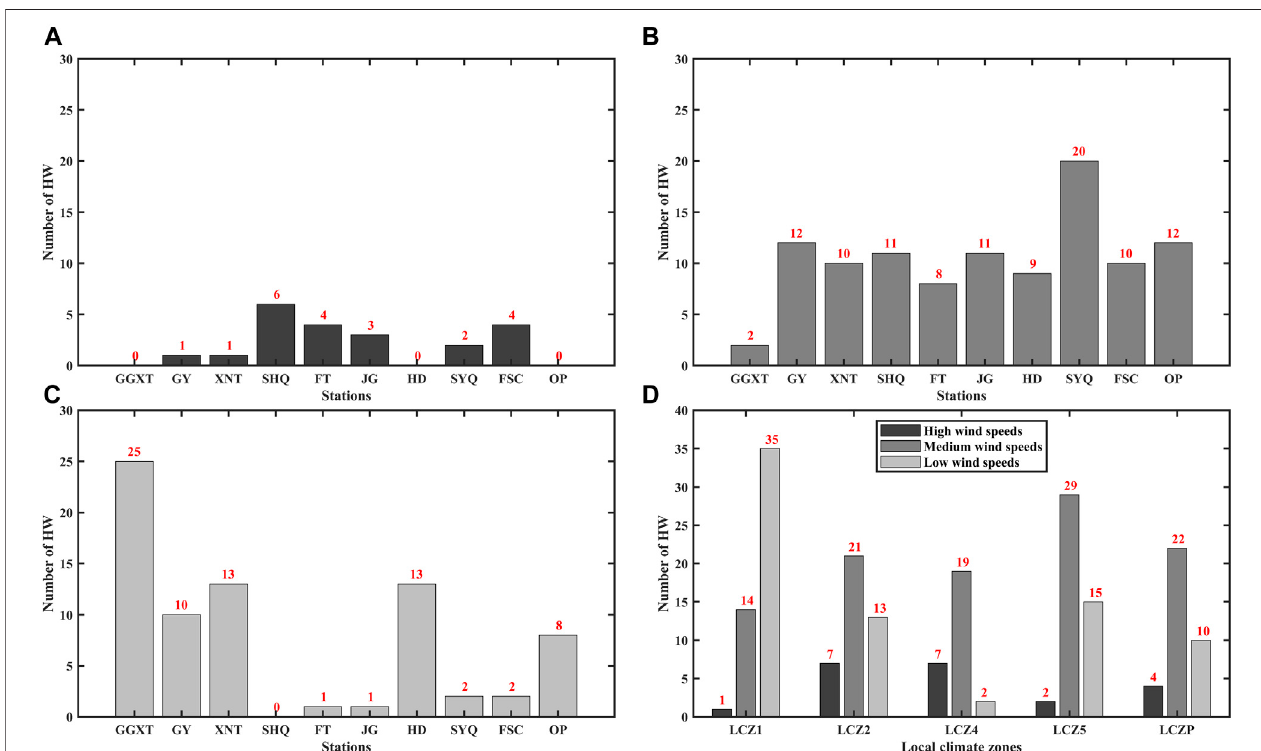
FIGURE4| NumberofHWeventsunderdifferentwindspeedconditionsateachurbanstationduring2014 – 2020: (A) highwindspeeds; (B) mediumwindspeeds; (C) low wind speeds; (D) wind speeds per LCZ.